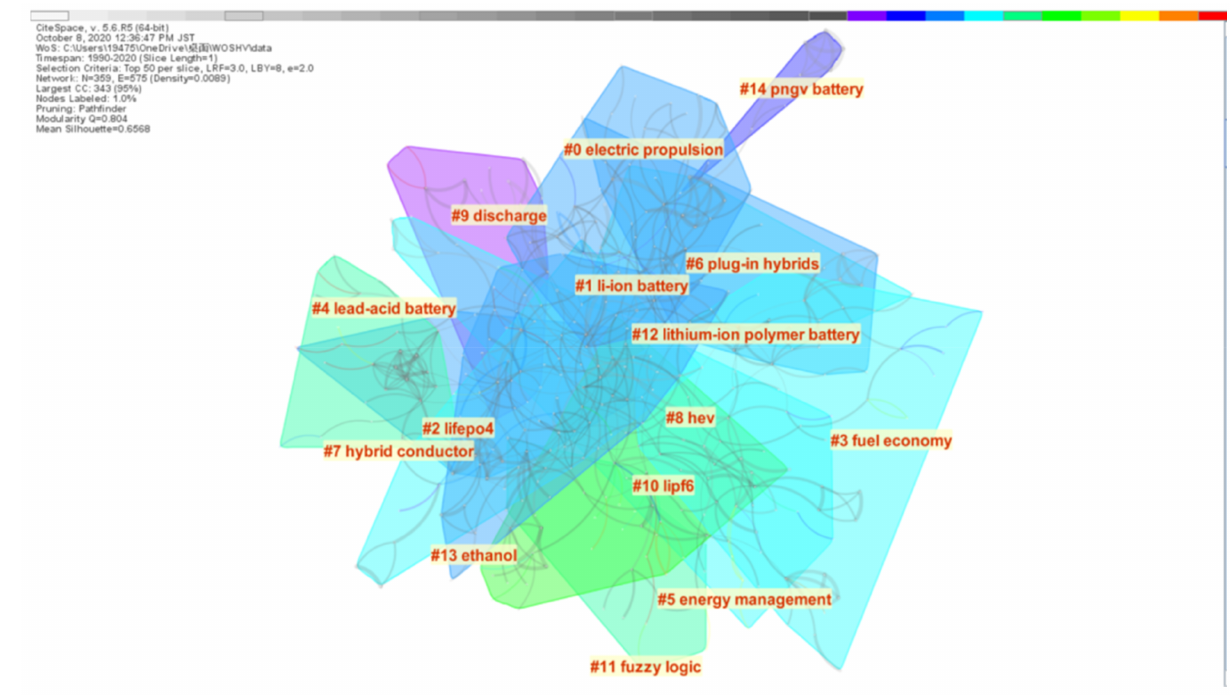
Figure 8. Popular topics of research on HVs and